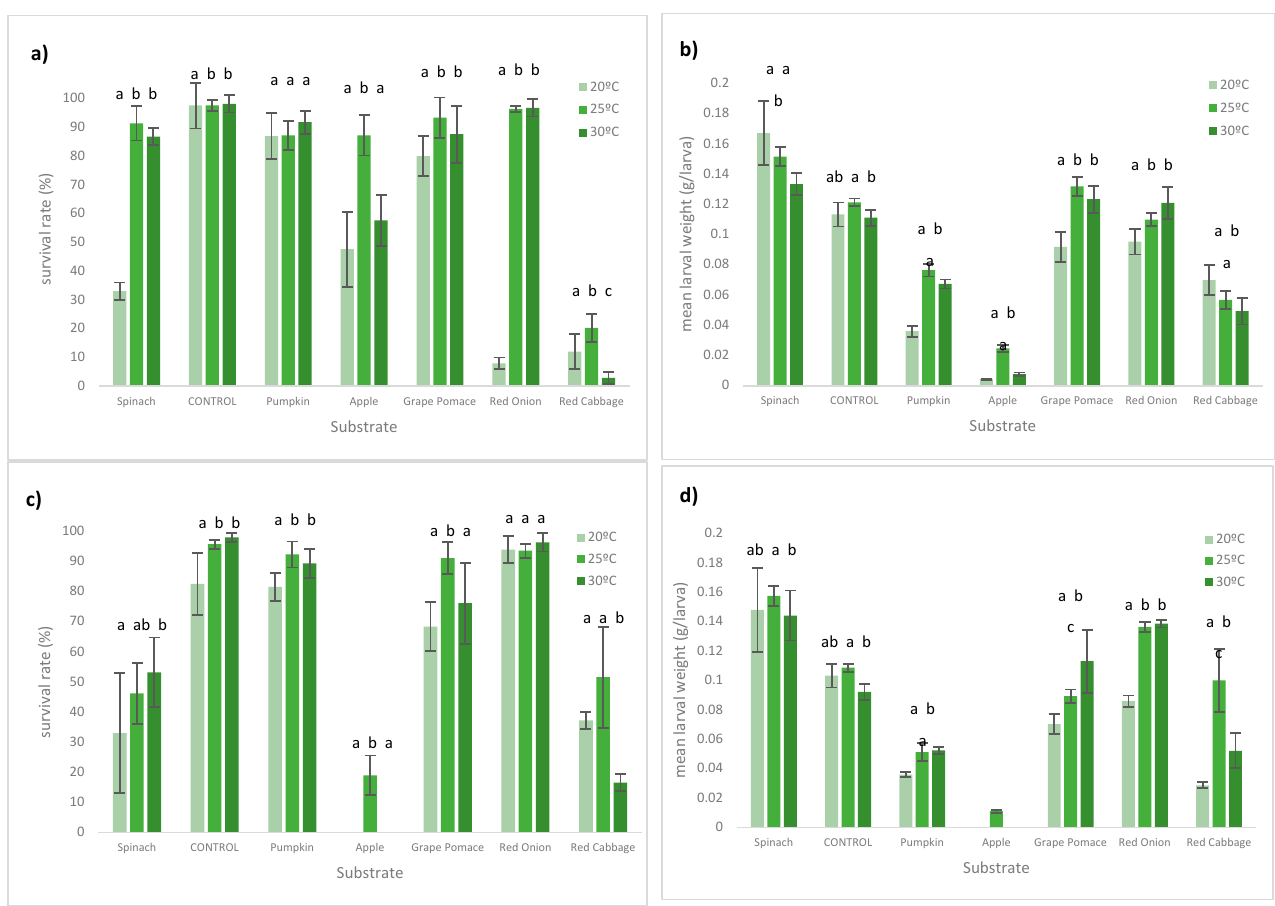
Figure 2. BSFL performances under different temperatures at the end of the trial. ( a ) Survival rates (%) at 70%SM; ( b ) average final biomass per larvae at 70%SM (larvae + prepupae ± SD); ( c ) survival rates (%) at NAT; ( d ) average final biomass per larvae at NAT (larvae + prepupae ± SD). Significant differences between the tested substrates ( p ≤ 0.05) are represented by different letters. Grape pomace weight at NAT SM was not included in the analysis.